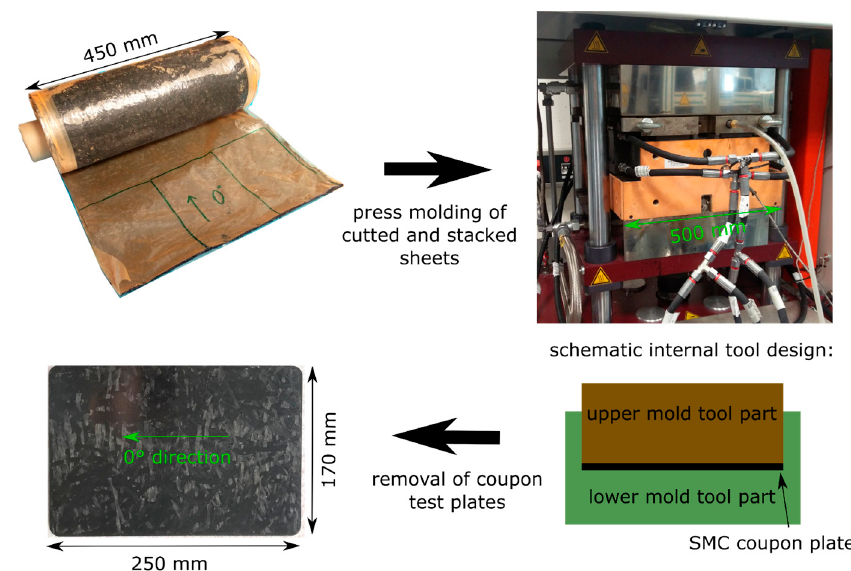
Figure 1. Processing of carbon fiber SMC ‘SMCarbon 80 CF60-3K/2’ from manufacturer Polynt into coupon test plates.